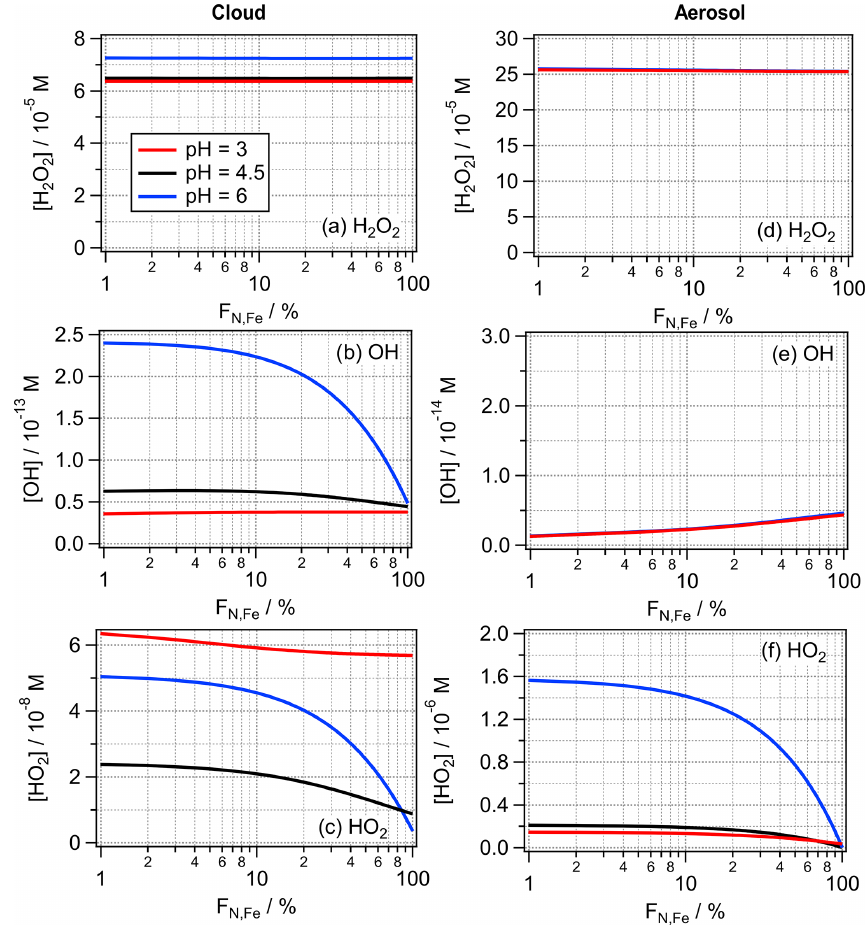
Figure 6. Bulk aqueous-phase concentrations of H 2 O 2 , OH and HO 2 for the cloud (a–c) and aerosol (d–f) cases as a function of F N , Fe using the model parameters listed in Table